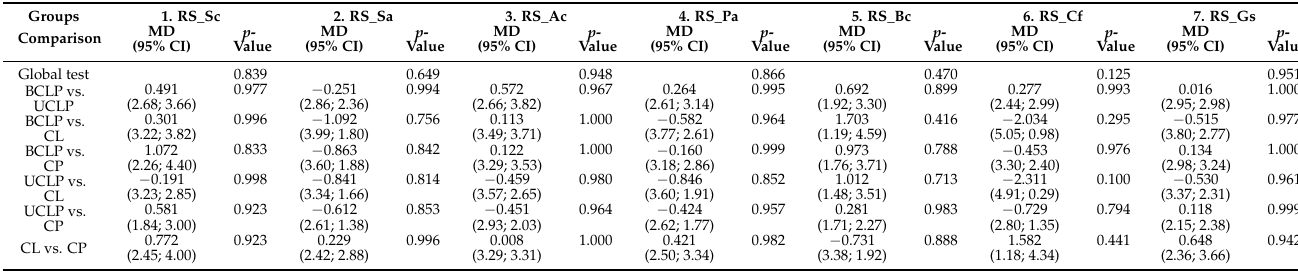
Table 6. Self-Esteem (CBSA).